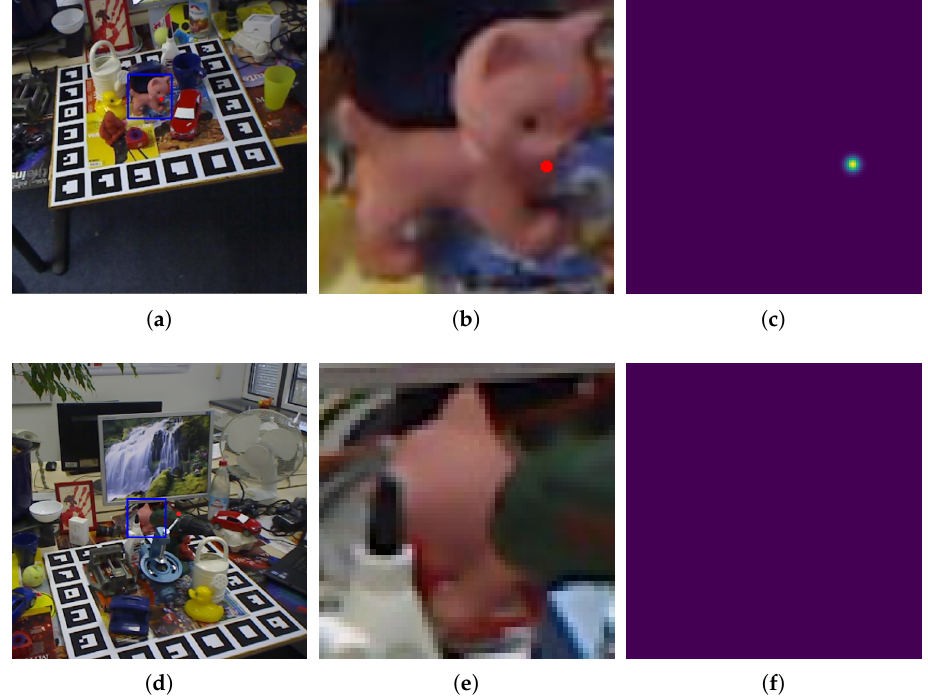
Figure 1. Heatmaps cannot perceive keypoints outside the image. The blue boxes are object bounding boxes and the red points are keypoints. ( a ) Unoccluded image; ( b ) Image block; ( c ) Heatmap for unoccluded keypoints; ( d ) Occluded image; ( e ) Image block; ( f ) Heatmap for occluded